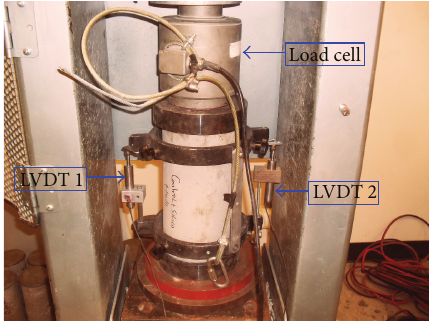
Figure 2: Compressive test (ASTM C39)